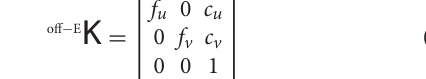
frames respectively (e.g., the rigid transformation between W and R C is